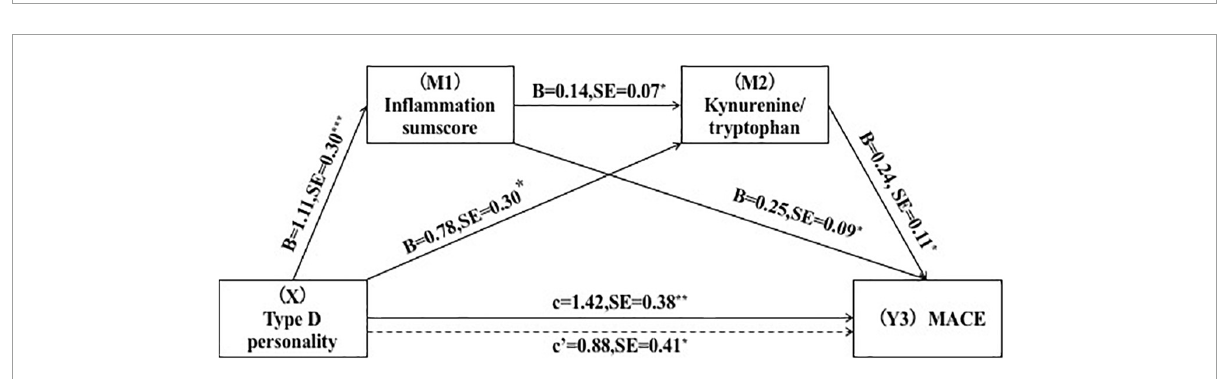
FIGURE4 Serial-multiple mediation of inflammation and kynurenine/tryptophan ratio in the relationship between Type D personality and MACE. * p < 0.05, ** p <